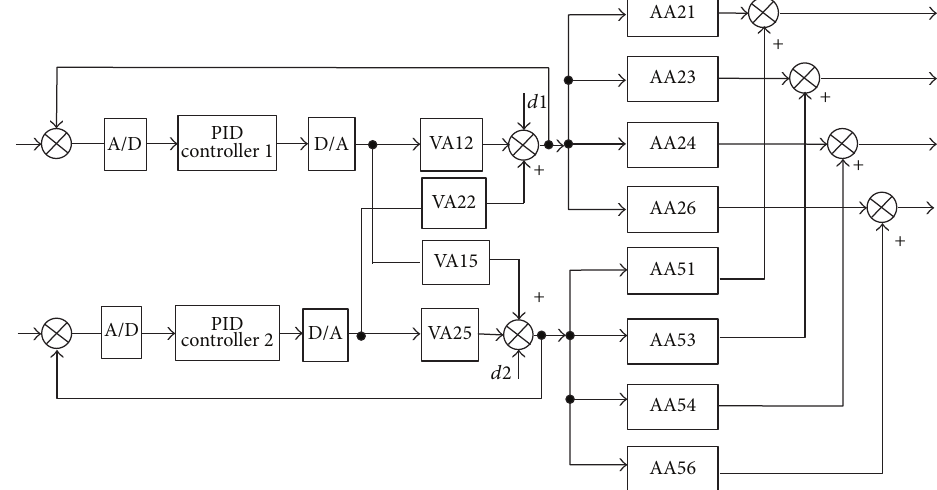
Figure 7: Control schematic diagram of multisources complex excitations active vibration isolation